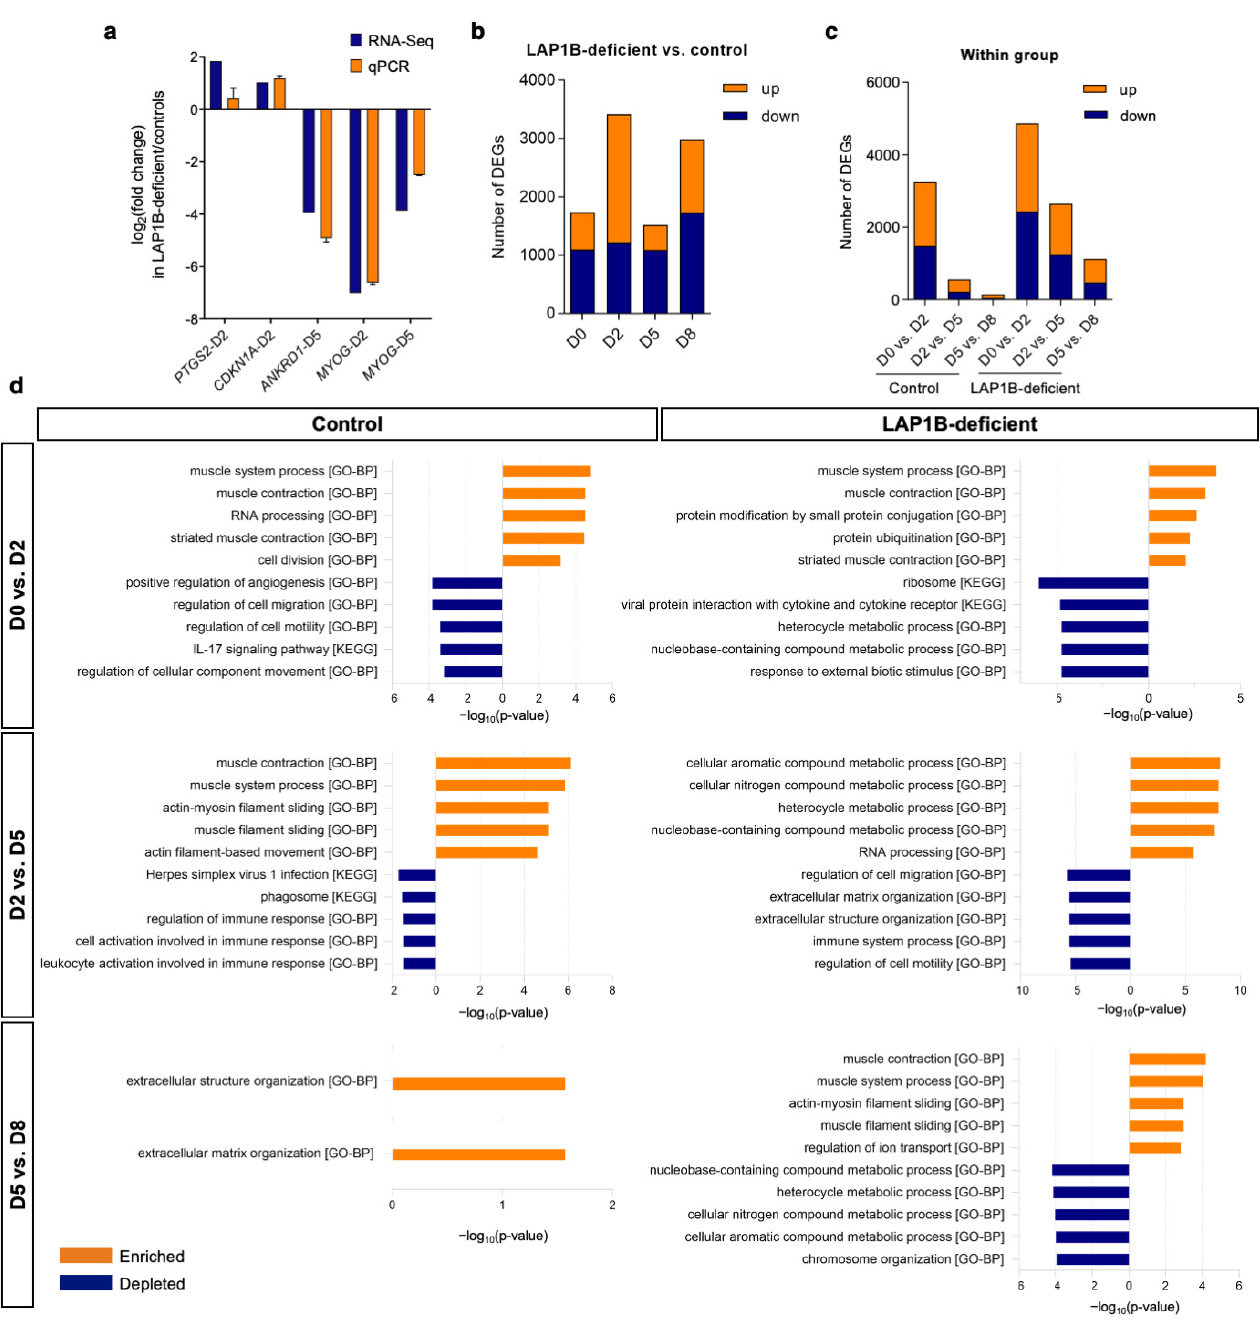
Figure 4. Time-course transcriptome profile of the control and LAP1B-deficient cells throughout MyoD-induced differentiation. ( a ) Validation of RNA-seq expression fold changes using qPCR. Log 2 values of expression fold changes obtained in the RNA-Seq and qPCR of PTGS2 at day 2, CDKN1A at day 2, ANKRD1 at day 5, and MYOG at day 2 and day 5 in the LAP1B-deficient cells relative to the controls. Expression was normalized to GAPDH ( n = 3). ( b ) Number of DEGs in the LAP1B-deficient cells compared to the controls at each day of differentiation. ( c ) Number of DEGs between consecutive days of differentiation within the controls and within the LAP1B-deficient cells. ( d ) Top five most significantly enriched and depleted GO-BP or KEGG categories at consecutive days of differentiation in the controls and LAP1B-deficient cells, which were obtained from gene set enrichment analyses using the Kolmogorov–Smirnov test and GeneTrail 3.2.